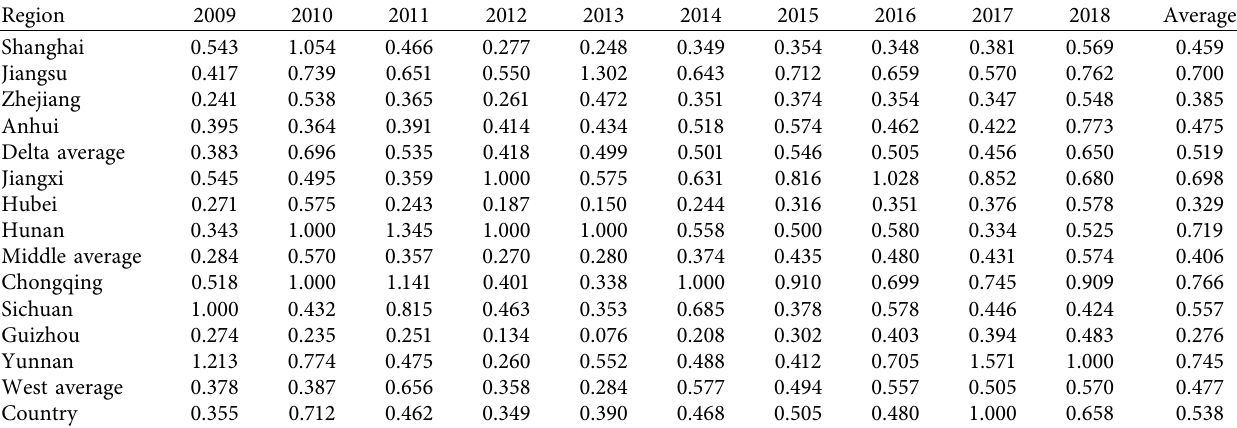
Table 2: Innovation efficiency of the high-tech industry in Yangtze Economic Belt from 2009 to 2018.